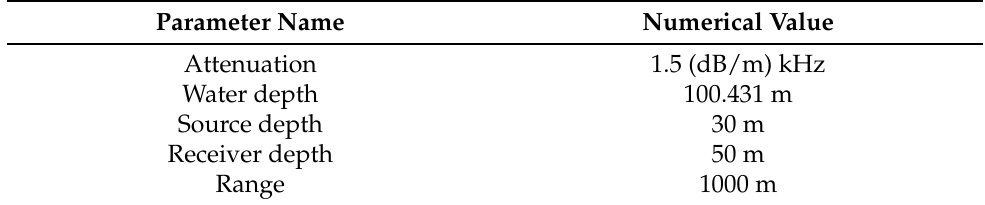
Table 1. Parameters of simulation